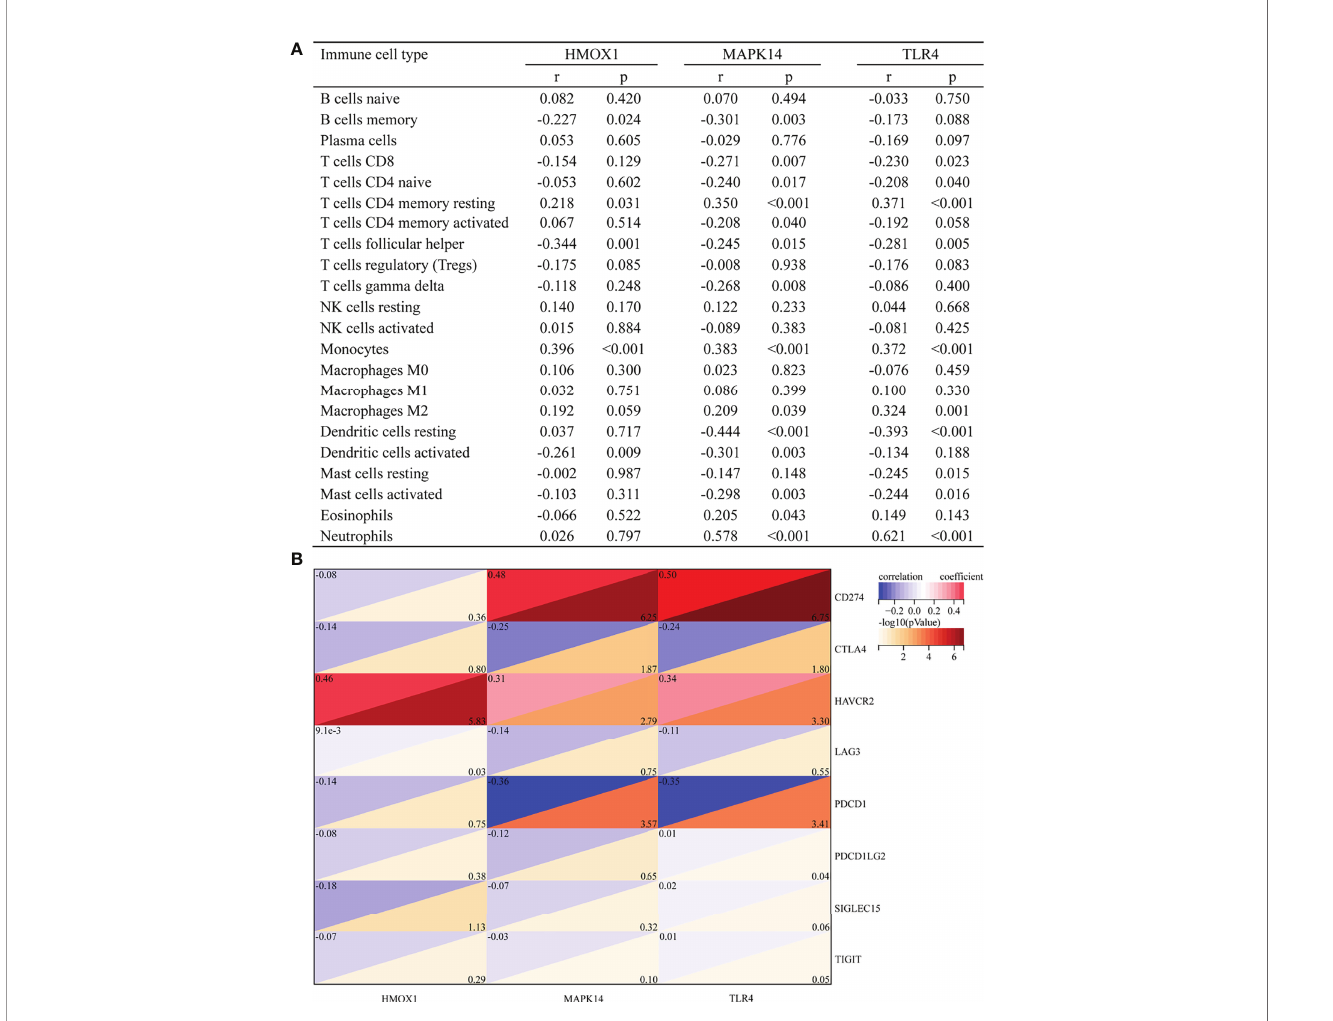
FIGURE 5 | Correlation between hub gene and immune cells and immune checkpoint genes. (A) Correlation between hub gene and immune cells. (B) Correlation between hub gene and immune checkpoint